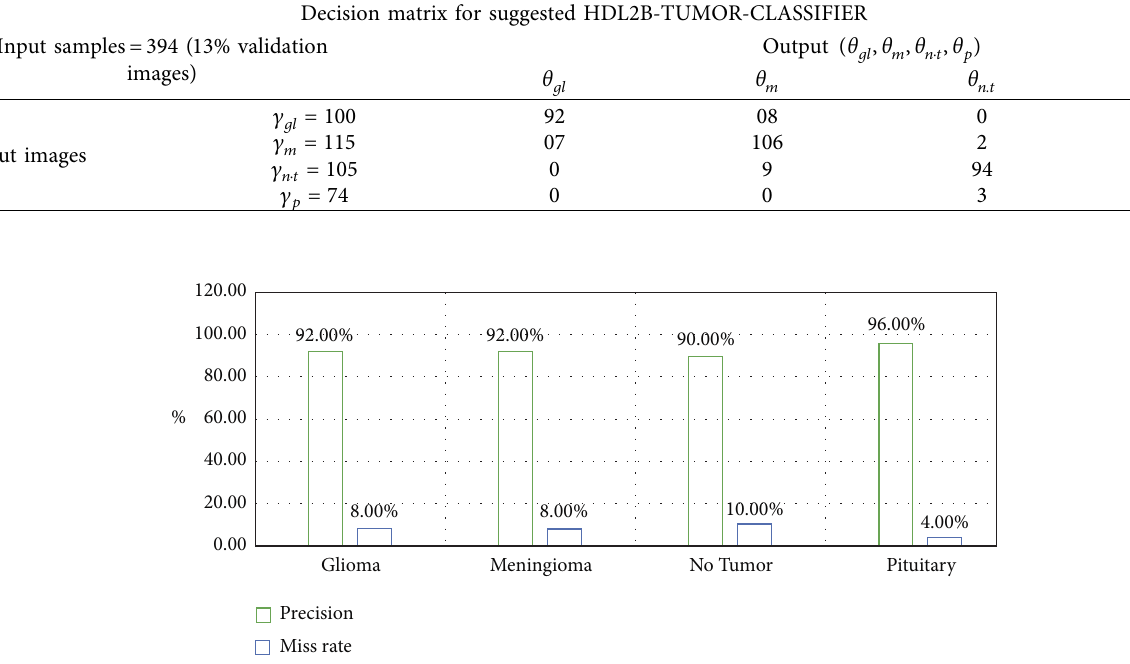
Figure 3: Performance of the proposed HDL2B-TUMOR-CLASSIFIER